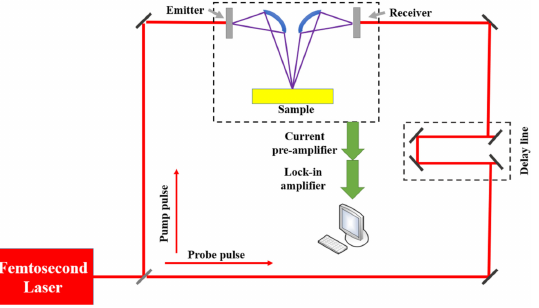
Figure 1. Schematic diagram of reflective terahertz TDS system module and optical